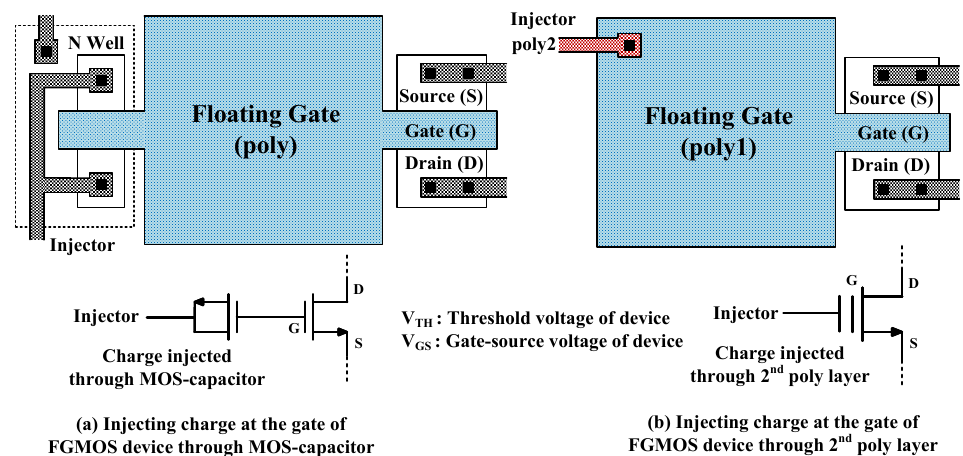
Figure 6. ( a ) Top view of the floating-gate MOSFET (FGMOS) device integrated with MOS-capacitor for charge injection into gate-oxide and ( b ) top view of the FGMOS device with an additional poly layer used for charge injection .